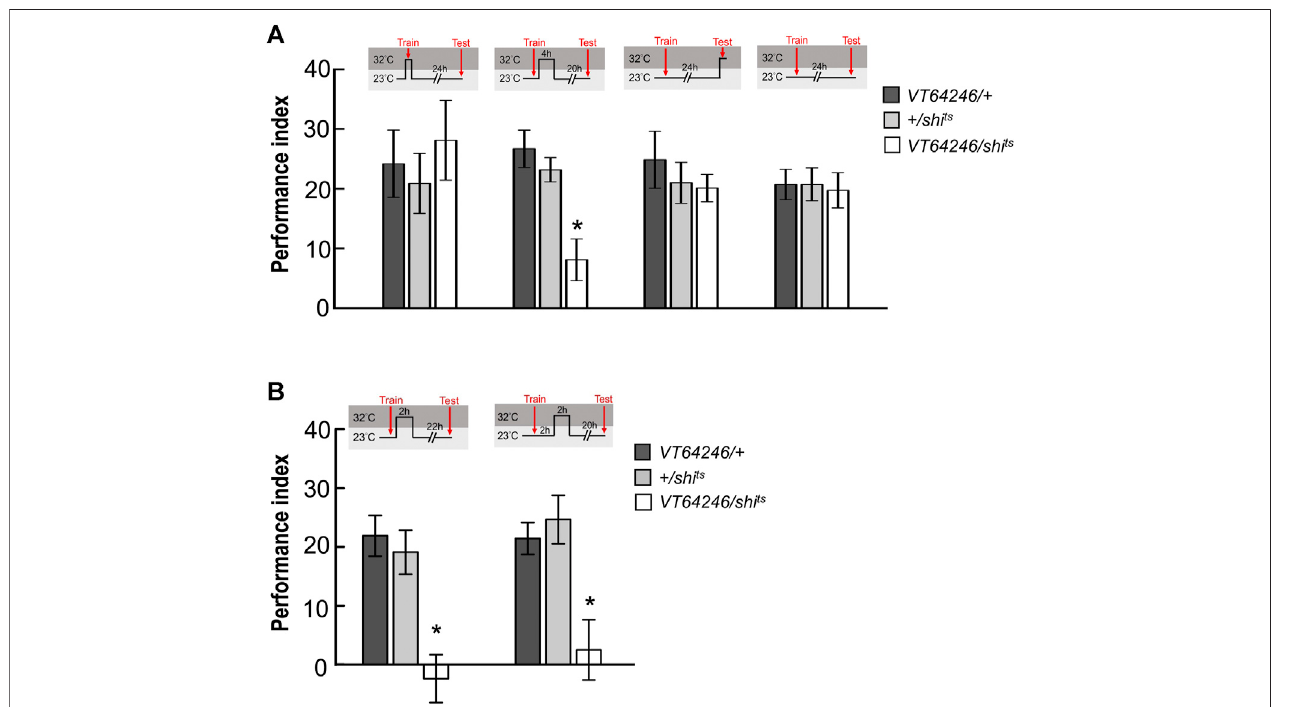
FIGURE 5 | Neurotransmission in DPM neurons is speci fi cally required for wLTM consolidation but not acquisition or retrieval. (A) Blocking neurotransmission in DPMneuronsvia shi ts duringmemoryconsolidation,butnotduringacquisitionorretrieval,disruptedwLTM.Eachvaluerepresentsmean ± SEM(N (cid:1) 10,9,8,10,11,11, 8, 8, 8, 8, 8, and 8 from left to right bars). * p < 0.05; one-way ANOVA followed by Tukey ’ s test. (B) Blocking neurotransmission in DPM neurons via shi ts at 0 – 2 h period (left panel) or at 2 – 4 h period (rightpanel) after training disrupted wLTM. Each value represents mean ± SEM (N (cid:1) 10, 10, 10,9, 9,and 8 fromleft toright bars). * p < 0.05; one-way ANOVA followed by Tukey ’ s